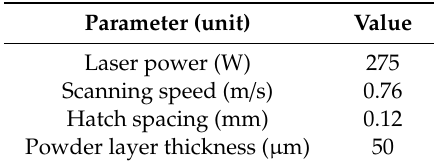
Table 1. AM parameters of the Ti-6Al-4V sample.